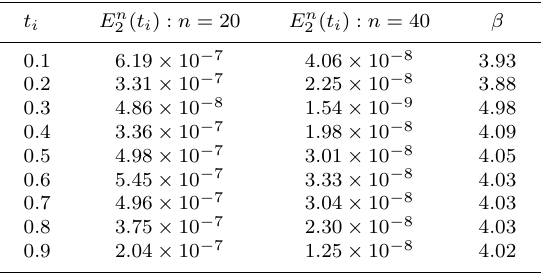
Table 2. Errors and convergence orders for the composite midpoint rule: extrapolation t